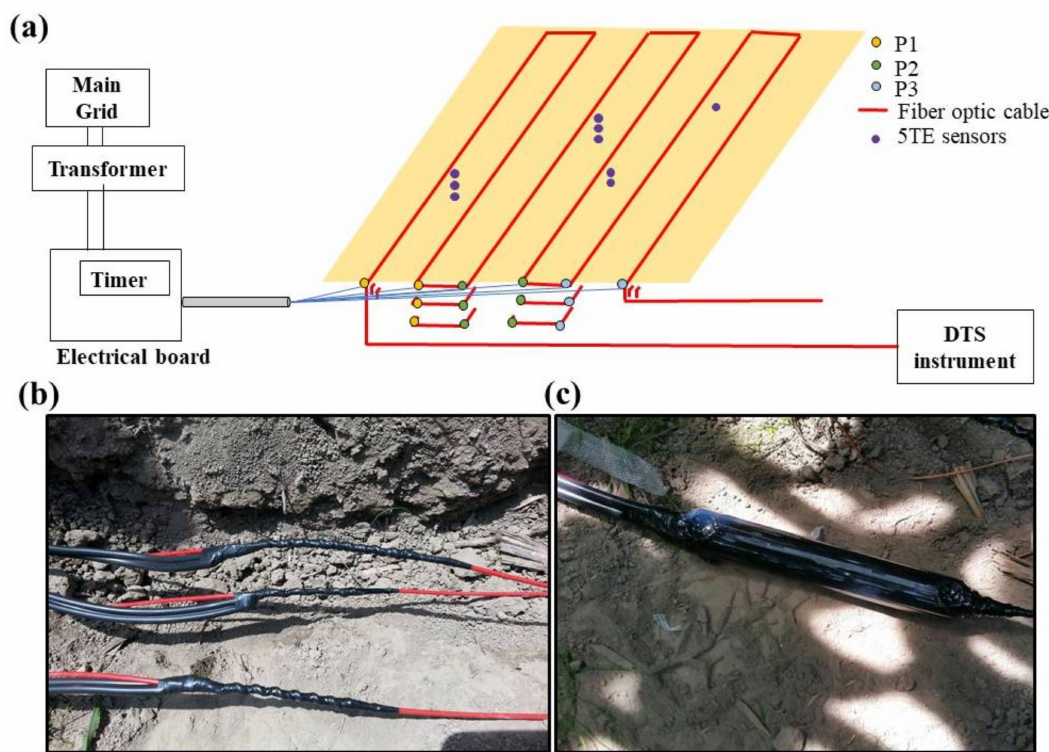
Figure 3. ( a ) Schematic of the power supply from the electrical grid, transformer and main electrical board including the digital timer which controlled the heat pulses (on right), electrical cables pairs connected to each heating cable section (on left); ( b ) shows the electrical connections made to the metal sheath of the fiber optic cable (wrapped with electrical insulating tape); ( c ) an electrical connection enclosed in a plastic container filled with insulating